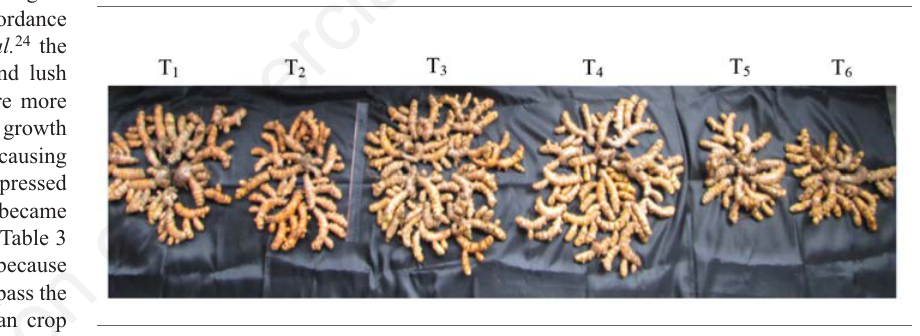
Figure 2. Fresh Curcuma Rhizome at Age 24 WAP on the Different Treatment cropping pattern T1 row cropping, T2 strip cropping, T3 row relay (T-K), T4 strip relay (T-K),